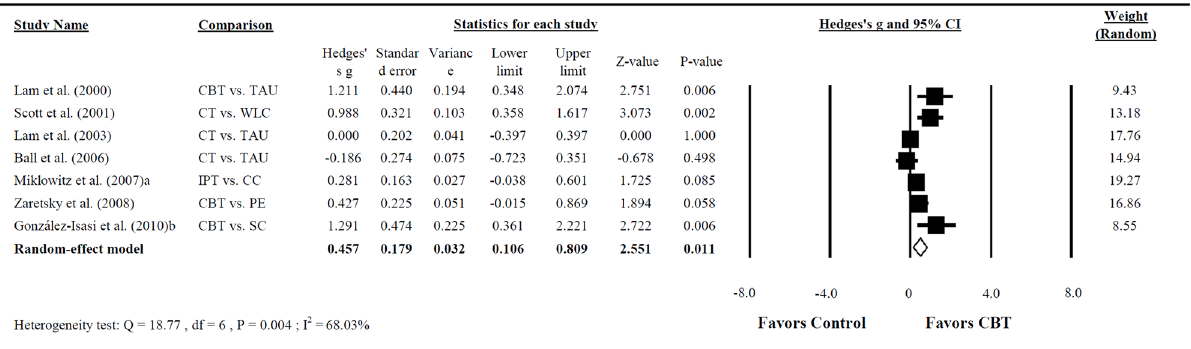
Fig 5. Forest plot of the meta-analysis for improving psychosocial functioning in BD among patients treated with CBT compared with controls (n = 7 studies).